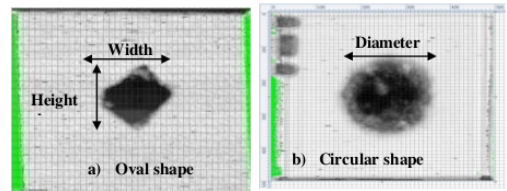
Figure 13: Approximation of typical damaged zone a) random and b) circular